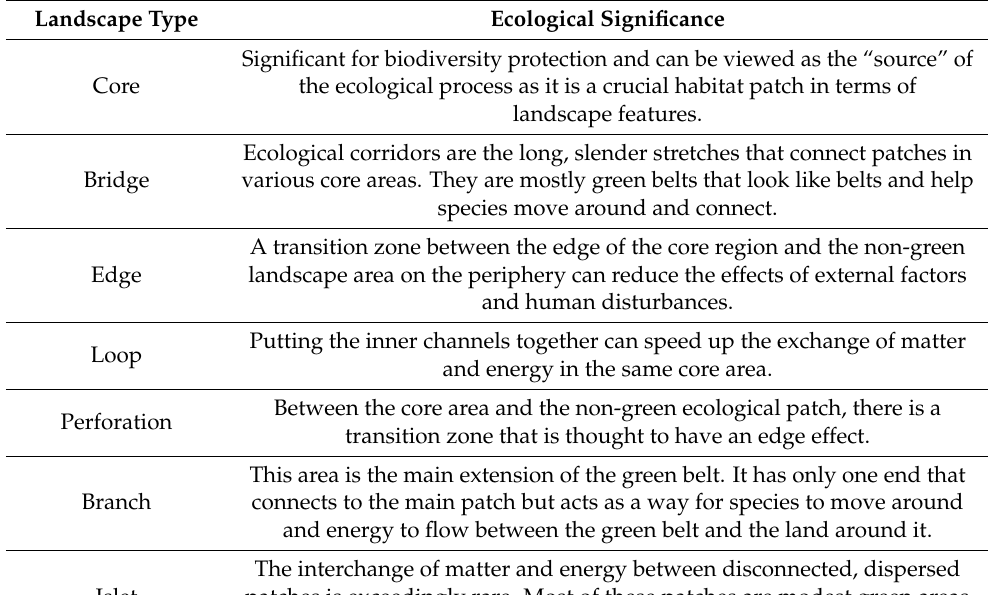
Table 2. Landscape types and ecological significance of